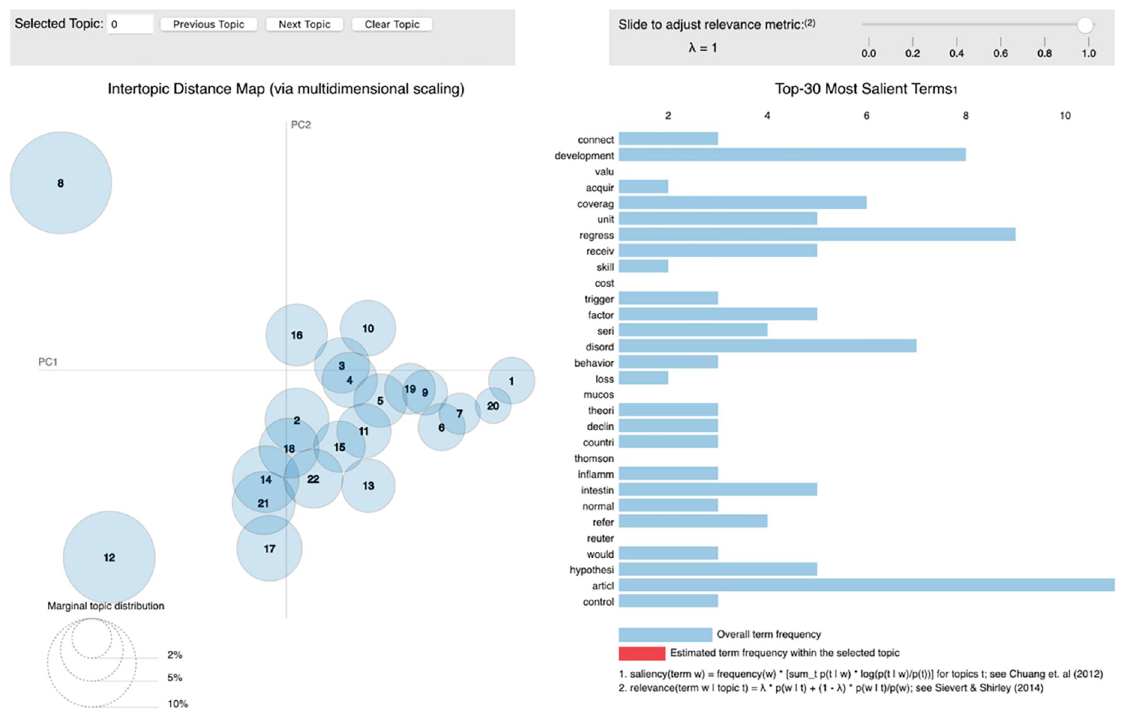
Fig 9. The LDAvis interface. The left side of the visualization plots the topics in a two-dimensional plane whose centers are determined by computing the distance between topics. On the right side LDAvis lists 30 terms ranked using the term saliency measure, this list might show the 30 terms ranked using the relevancy measure of a specific topic if selected from the left graphic.